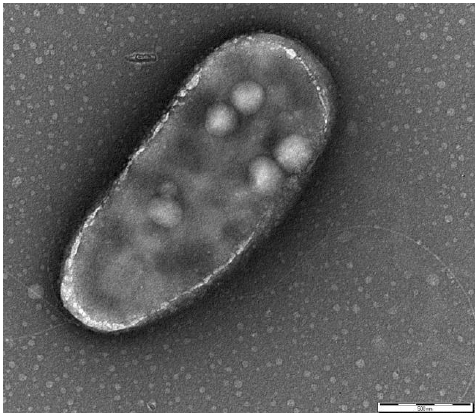
Figure 1. Transmission electron micrograph of Pseudomonas fluorescens HK44 encapsulated in a silica gel (reprinted from [38] with